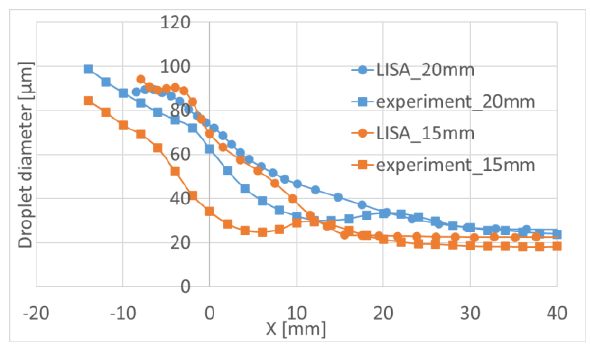
Fig. 15 Comparison of droplet diameter predicted by LISA and obtained by PDA measurement for two axial locations (15 and 20 mm) from the nozzle tip for 16